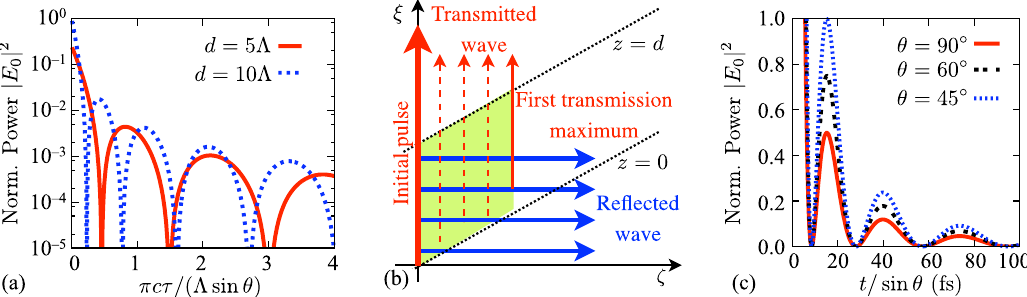
FIG. 4. (a) Time dependence of the Bragg forward diffraction intensity for a crystal thickness that is 5 and 10 extinction lengths. The position of first intensity maximum scales as 1 =d while its peak power / ð d= sin (cid:2) Þ 2 . Note that in both cases there are several transmission maxima over a time interval for which Fig. 3(a) shows only one single reflection peak. (b) Illustration of the coupled forward and reflected modes in Bragg diffraction. The crystal surfaces are shown as dotted lines with unit slope. The initial pulse excites a reflected wave (blue arrows) that propagates along the (cid:7) characteristic, which in turn excites forward-scattered waves (dotted red arrows) that move along (cid:8) . The first transmission maximum is determined by the coupling area shaded green, meaning that the time delay of the first maximum scales inversely with d . (c) Time dependence of Bragg forward diffraction intensity, plotted as a function of t= sin (cid:2) for the (004) reflection in diamond with d ¼ 0 : 15 mm . The power maxima line up on the normalized t= sin (cid:2) scale, with the peak scaling as ð d= sin (cid:2) Þ 2 . The central wavelength (cid:12) 0 (cid:8) ð 1 : 79 (cid:4)A Þ sin (cid:2)